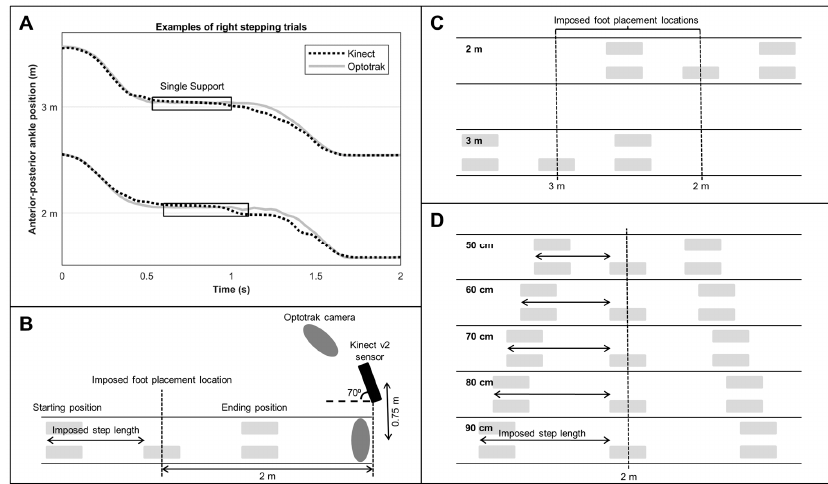
Figure 1. ( A ) Representative example of the right anterior-posterior ankle position for the Kinect v2 sensor (dotted black line) and a gold-standard Optotrak system (solid gray line) during two right stepping trials (at 2 m and 3 m distance from the sensor with the Kinect v2 sensor positioned at 0 m and walking direction towards the sensor). The single-support phase is indicated by the black boxes; ( B ) Schematic overview of the experimental set-up together with a right stepping trial at a 2 m distance from the sensor; ( C ) Schematic overview of the two imposed foot placement locations distanced 2 m (top) and 3 m (bottom) from the Kinect v2 sensor for right stepping trials; and, ( D ) Schematic overview of the different imposed step lengths for right stepping trials at a 2 m distance from the sensor.